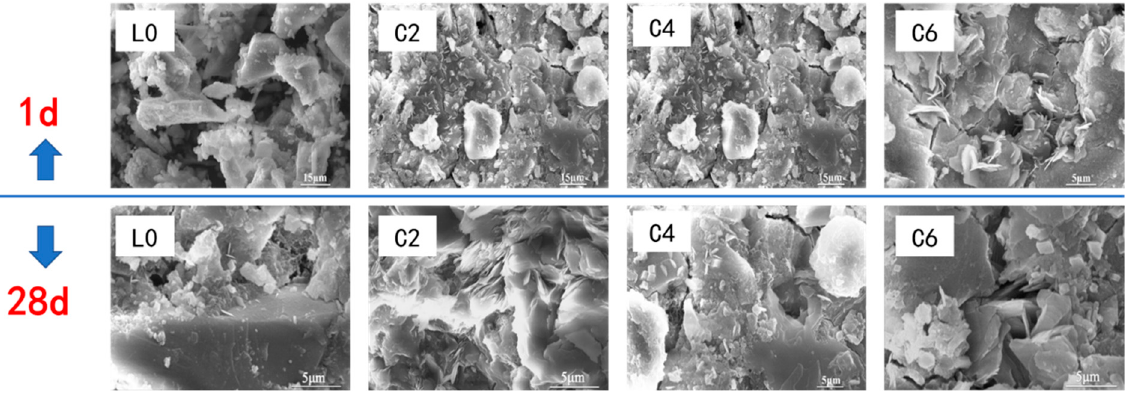
Figure 5. Microstructure morphologies of samples with different dosages of C-S-H seeds after 1 d and 28 d of reaction.